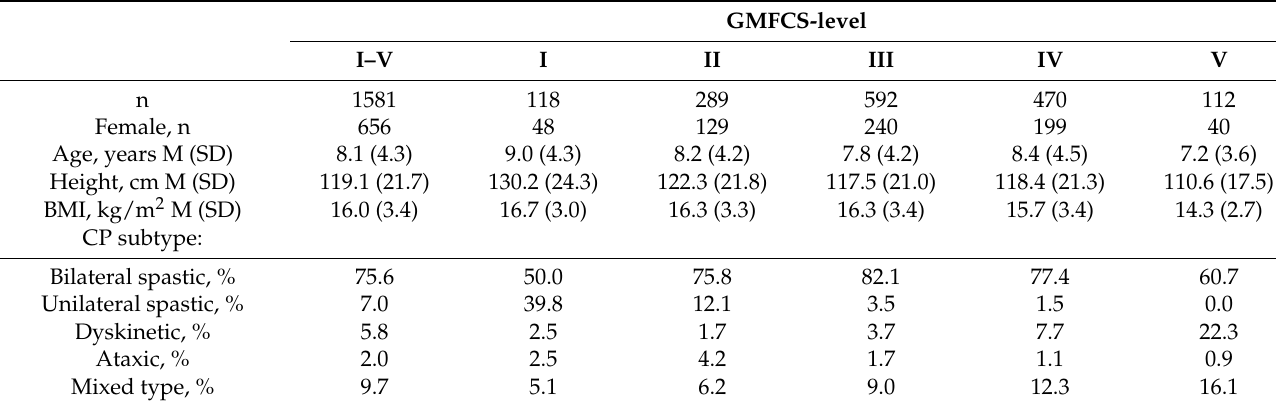
Table 1. Study population by GMFCS-level.